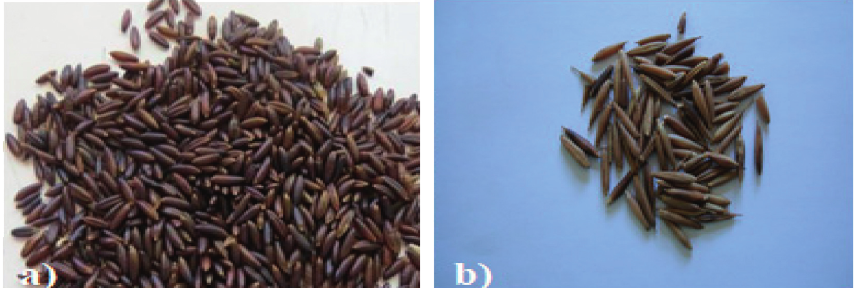
Figure 7: Fresh collected seeds of (a) O. alpina from Hula district and (b) O. abyssinica from Assosa district after mass flowering and fruiting in 2017.